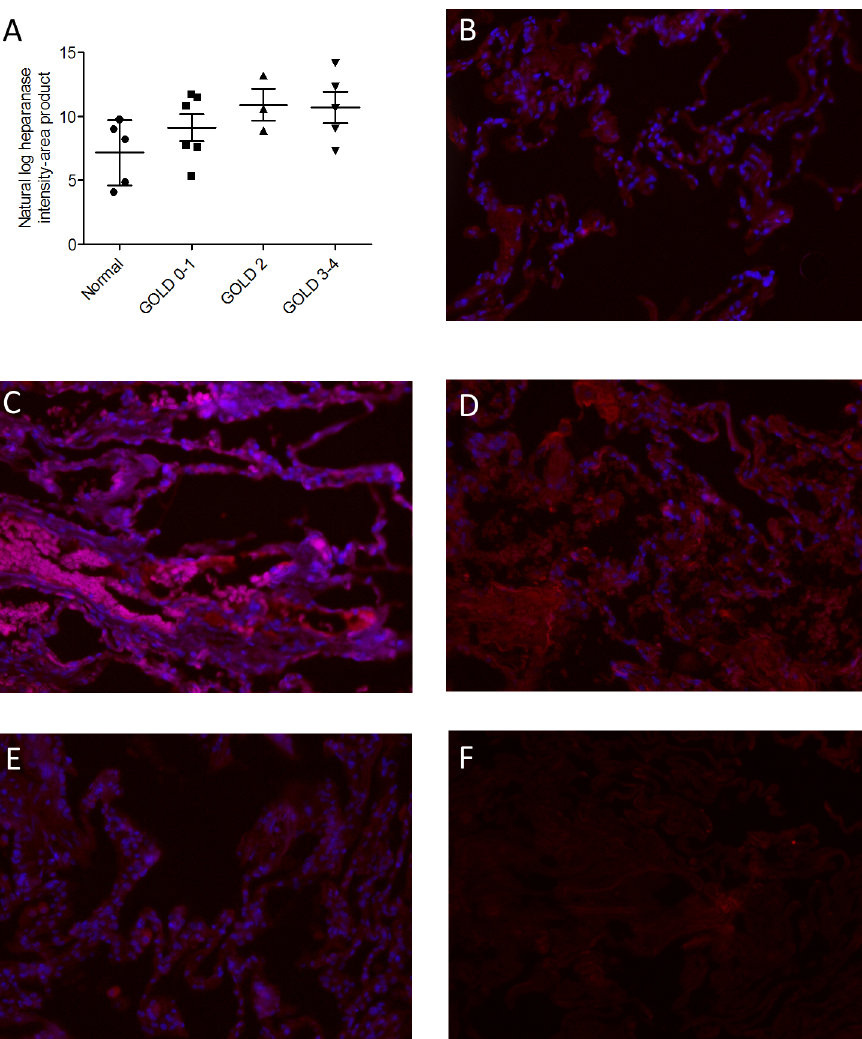
Fig 4. Heparanase expression in lung tissue from normal subjects and COPD patients of varying severity. Each point represents the intensity of staining for heparanase expression in normal human lung tissue and in subjects with varying severities of COPD (A). Representative images are shown (B-F reflecting Gold 0 – 1, Gold 2, Gold 3 – 4, healthy subject, and isotype control, respectively. Red: heparanase; blue: DAPI (DAPI not performed for isotype control). Image brightness was uniformly adjusted for clarity and all heparanase quantification was performed using unadjusted (raw) images. Magnification was 40 x for all images. The data was analyzed as continuous variables and there was a significant linear trend (post- ANOVA, r-squared = 0.27 and p = 0.029). Horizontal line represents mean and limits represent SEM.